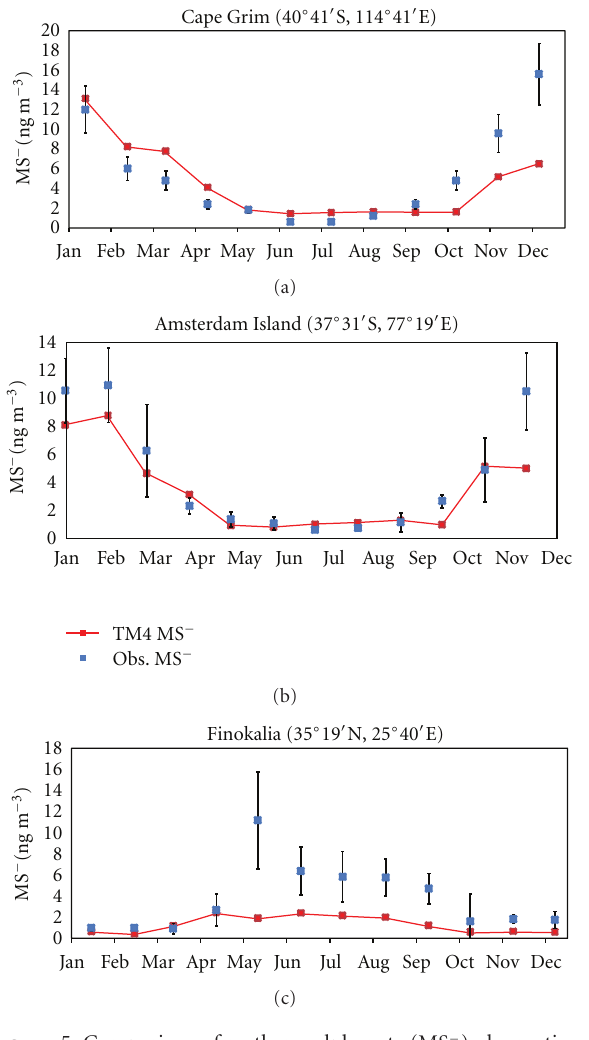
Figure 5: Comparison of methanesulphonate (MS − ) observations with model results . Observed (filled squares with standard deviation bars) and model MS − (solid line red squares) at: (a) Cape Grim (40 ◦ 41 (cid:5) S, 114 ◦ 41 (cid:5) E; [17]) (b) Amsterdam Island (37 ◦ 31 (cid:5) S, 77 ◦ 19 (cid:5) E; [41]), (c) Finokalia (35 ◦ 19 (cid:5) N, 25 ◦ 40 (cid:5) E; [42]). All values are in ngm − 3 .